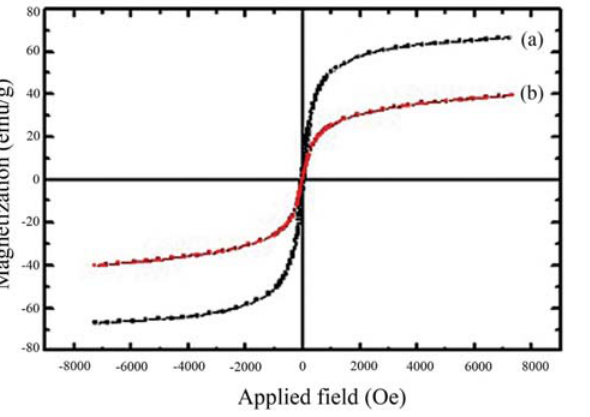
O nanoparticles (a) and 3 4 O (b). 3 4